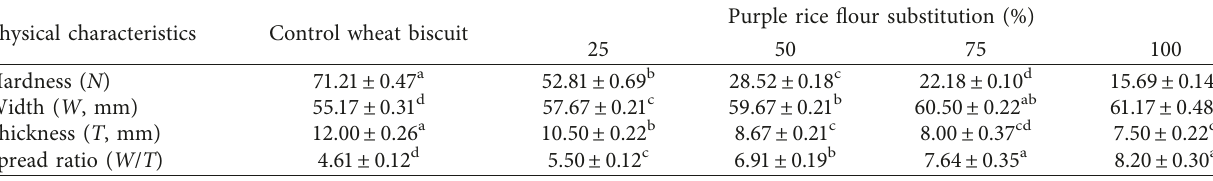
Table 3: Physical and textural characteristics of the biscuits containing different levels of purple rice flours ∗